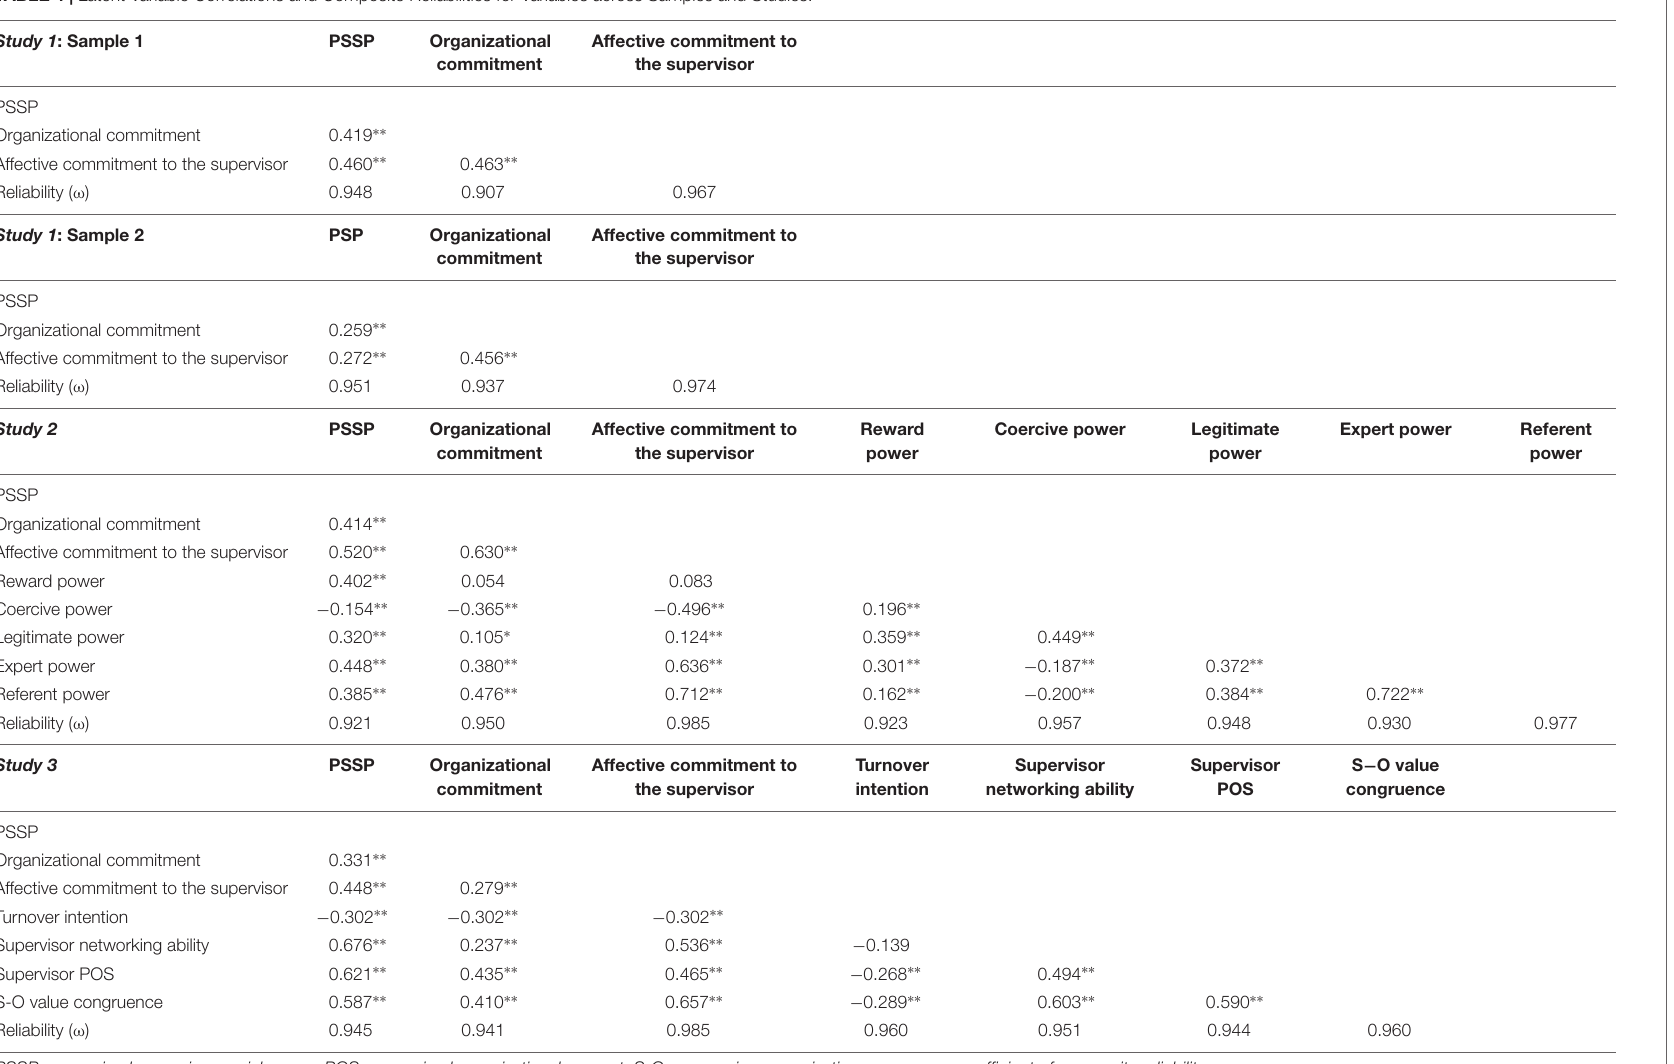
TABLE 4 | Latent Variable Correlations and Composite Reliabilities for Variables across Samples and Studies. Study 1 : Sample